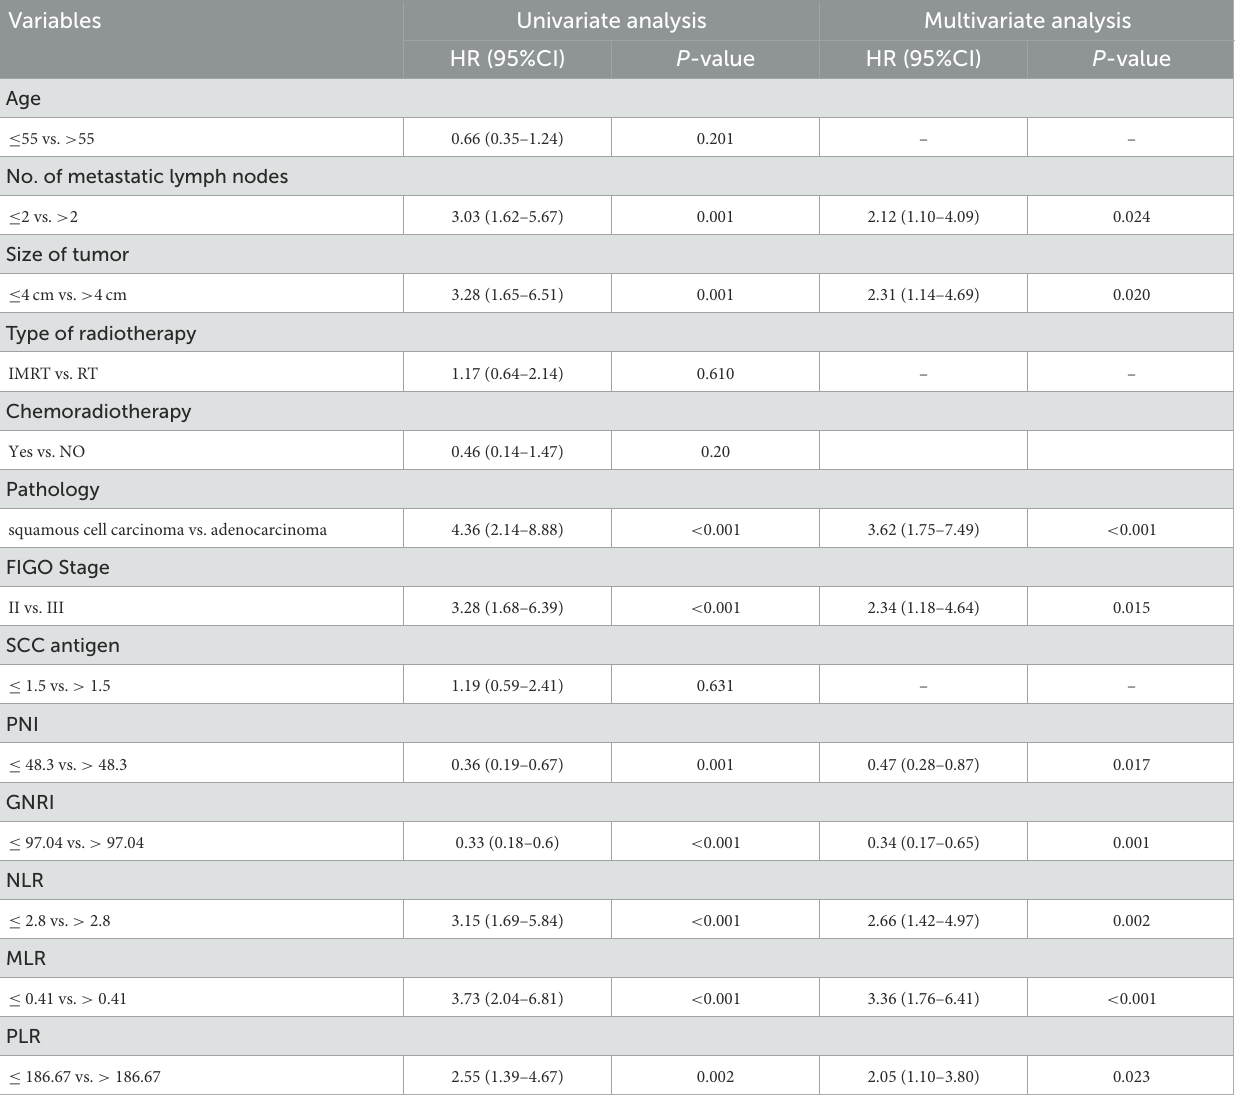
TABLE 3 Univariate and multivariate analysis for progression-free